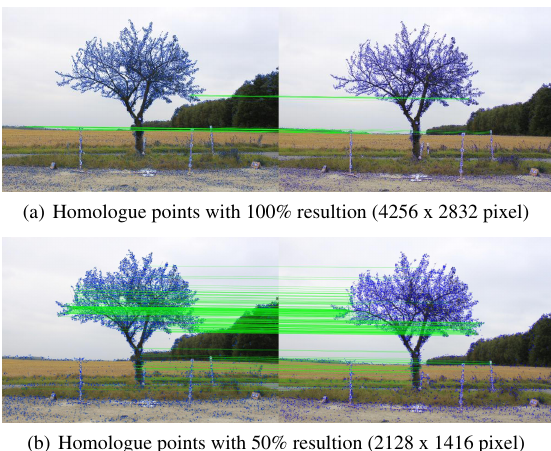
Figure 3: Different number of feature points, due to different res- olution image resolution